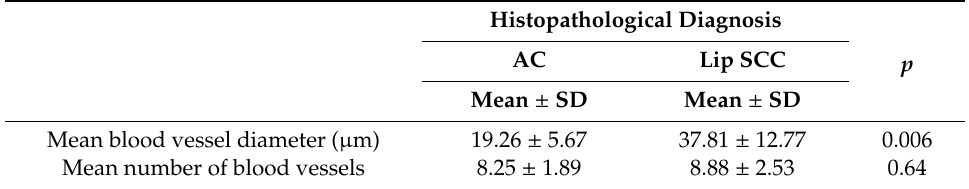
Table 6. Blood vessels characteristics of patients with AC and lip